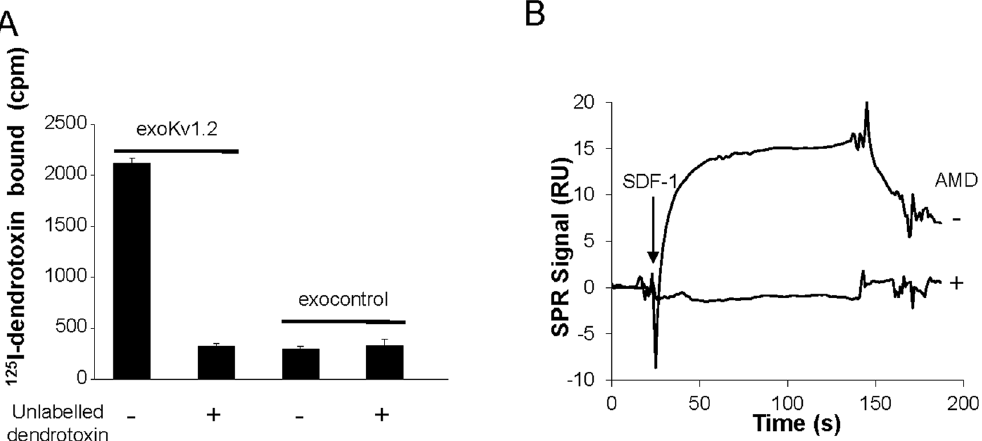
Figure 3. Measurement of ligand binding to exoKv1.2 and exoCXCR4. ( A ) Binding of 125 I-dendrotoxin to exoKv1.2. Exosomes were incubated with 125 I-dendrotoxin in the absence or presence of an excess of unlabelled dendrotoxin and bound toxin counted (cpm = counts per minute). Error bars are SD from triplicates. Representative from 4 independent experiments. ( B ) SDF1 binding to CXCR4 exosomes. The CXCR4 ligand SDF-1 (50 nM) was injected over exoCXCR4 immobilized on a chip. SDF-1 binding was measured and its specificity confirmed using the CXCR4 antagonist AMD3100 (10 µ M). Note that, as SPR monitors the mass of bound analyte, AMD3100 binding was not detected owing to it’s low molecular mass relative to SDF-1. Representative SPR sensorgrams, after blank subtraction, from 3 independent